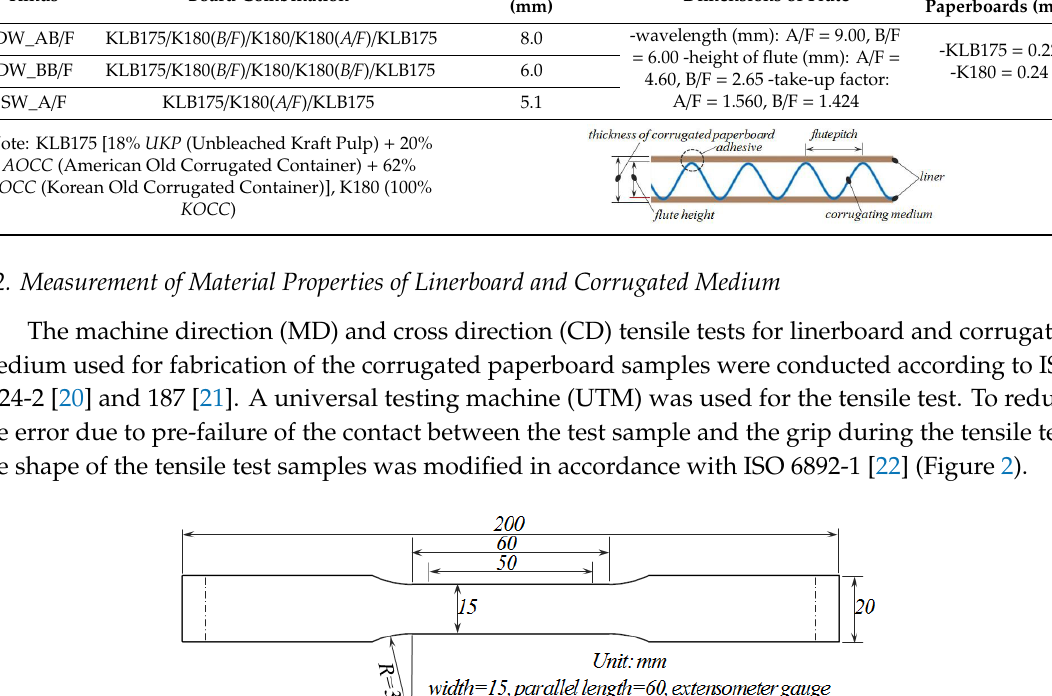
Table 1. Specifications of the target corrugated paperboards. Figure 1. Three principal material axes in corrugated paperboard and its components.